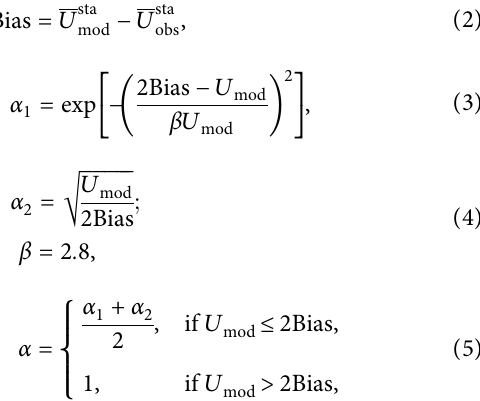
Figure 2: Location of Bac Lieu